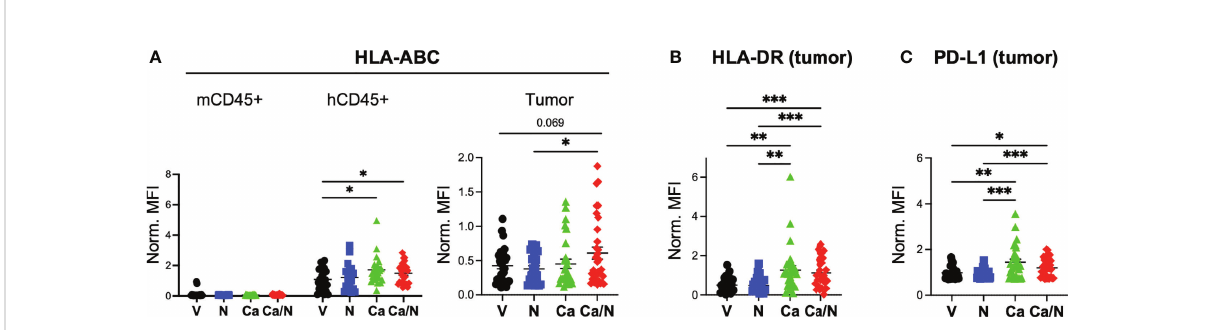
FIGURE 4 Increased MHC Class I, Class II and PD-L1 expression on CRC MSS tumors explanted from HIS-BRGS mice treated with cabozantinib, alone, and in combination with nivolumab. Mean fl uorescence intensity (MFI) of MHC Class I (HLA-ABC, A ), MHC Class II (HLA-DR, B ) and PD-L1 (C) on mCD45-,hCD45-, EpCam+ CRC MSS tumor cells explanted from HIS-BRGS mice treated with V=untreated, N=nivolumab alone, Ca=cabozantinib alone and Ca/N=combination cabozantinib and nivolumab. Expression of HLA-ABC MHC class I is shown on both mCD45+ cells and hCD45+ cells, as negative and positive controls, respectively (A) . P-values indicate ANOVA multiple comparisons with Welch ’ s correction: *p < 0.05, **p < 0.01, ***p < 0.001, or as indicated by